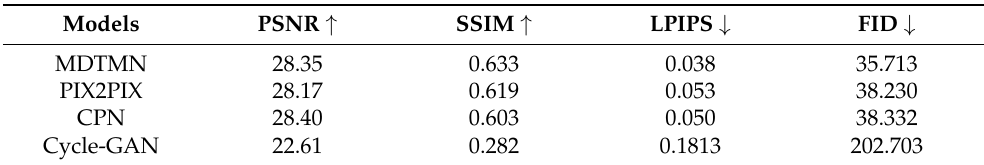
Table 2. Evaluation of the generation results of each algorithm under the reference of Ground Truth images.